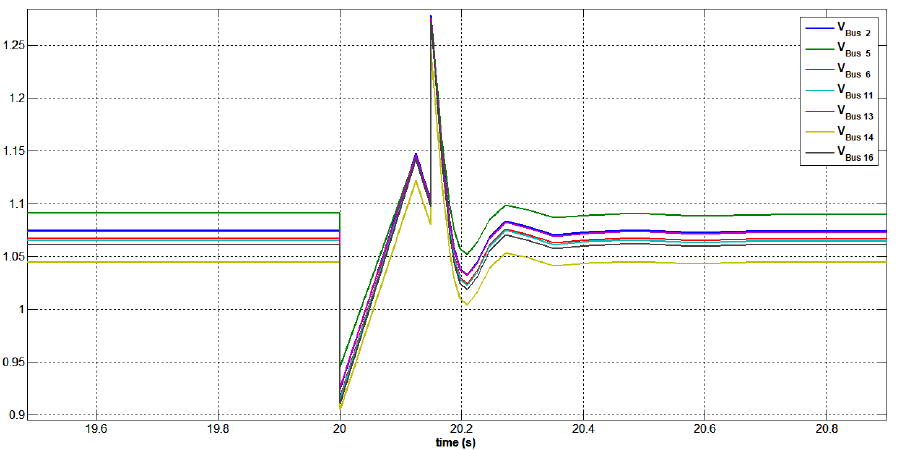
Figure 41. Voltage variation at buses 2, 5, 6, 11, 13, 14, and 16 after a three-phase short circuit at bus 15 without STATCOM.